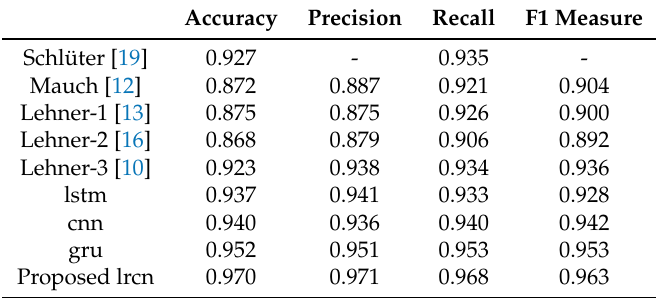
Table 4. Proposed singing voice detection system compared with existing methods on the RWC pop